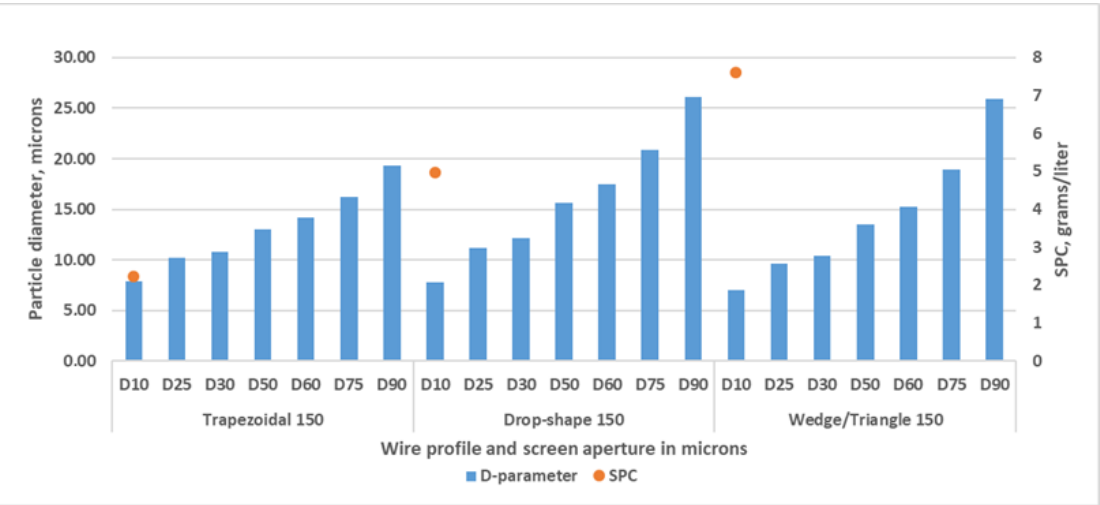
Figure 5. Scheme of the installation for Prepack SRT implementation [by authors].